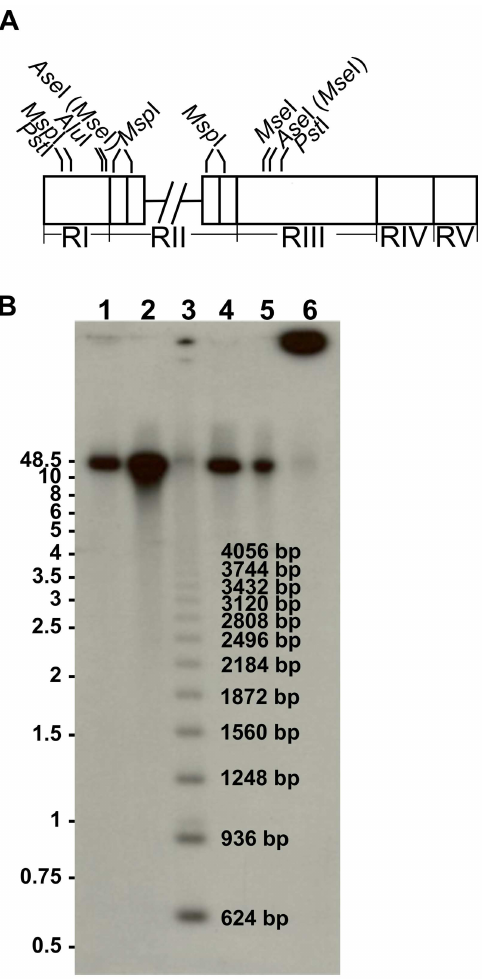
Figure 4. Estimation of 312-bp repeat copy number by Southern blotting. (A) Schematic diagram of the Mp AFP coding region illustrating the relative positions of restriction enzyme cut sites. Cross-hatched lines indicate the break between the two segments of Mp AFP coding region described in Fig. 3. Four restriction enzymes, including Mse I, Ase I, Pst I and Alu I cut only outside the 312-bp repeats. Since the cut site of Mse I (T/TAA) is present within that of Ase I (AT/ TAAT), Mse I is indicated in parentheses beside Ase I. Msp I is the only restriction enzyme in this set that cuts within the 312-bp repeats in RII, and it also cuts once in RI. (B) Southern blot of the digests using a 2 6 312-bp repeat from RII as the probe. Undigested DNA (lane 6) remained near the well, whereas the four restriction enzymes Alu I, Pst I, Ase I and Mse I (lane 1, 2, 4 and 5) that cut outside the repeats produced a fragment of approximately 37,500 bp in length. The Msp I (lane 3) partial digest produced a ladder of bands at 312-bp intervals and those containing between 2 (624 bp) and 13 (4056 bp) repeats are marked on this blot. DNA length markers (kb) are indicated on the left of the blot.